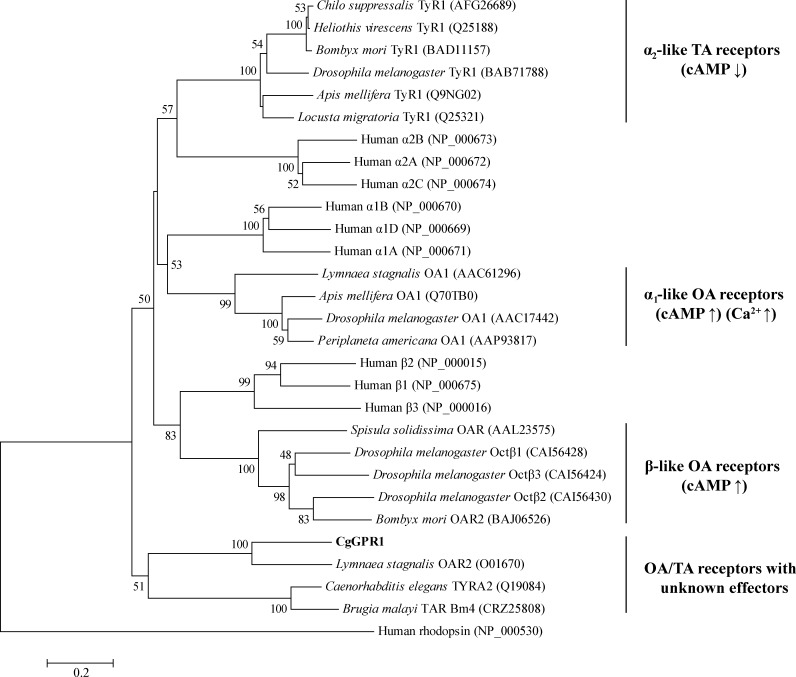
Phylogenetic tree of CgGPR1 and various biogenic amine receptors.The tree was built by the Neighbor Joining method with a JTT matrix-based model using 259 amino acid positions. Bootstrap analysis of 1000 replicates was conducted and values above 50% are shown. The scale for branch length is shown below the tree. Human rhodopsin receptor (NP_000530) was used as an outgroup.